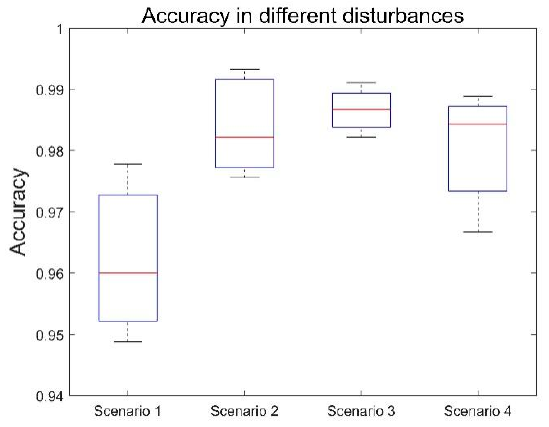
Figure 14. Performance under different